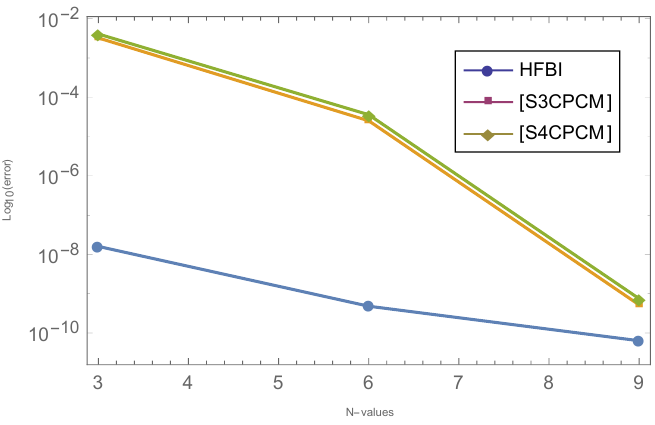
Figure 4. Efficiency curve for Problem